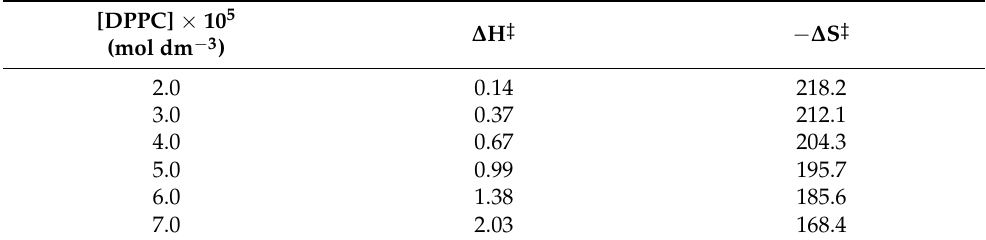
Entropy and Enthalpy of activation is symbolized ∆ S ‡ and ∆ H ‡ .